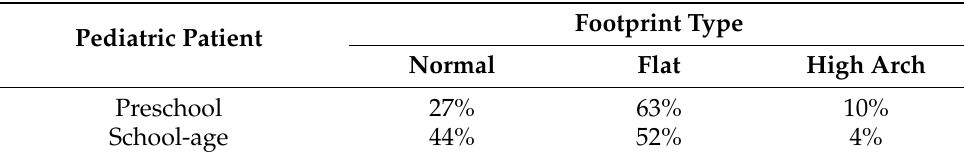
Table 7. Footprint analysis of pediatric